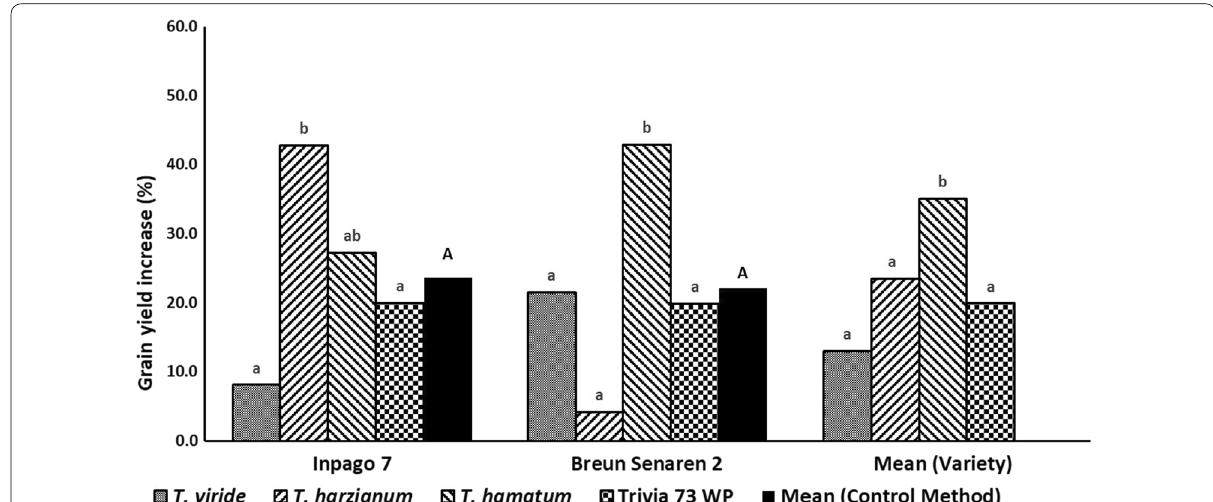
Fig. 1 Mean percentage of grain yield increase under combined treatments of disease control method and upland rice variety. Lowercase denotes comparison among disease control methods within the same variety or mean variety; uppercase denotes comparison between Inpago 7 and Breun Senaren 2. Values/bars within the same group with the identical lowercase or uppercase are not significantly different based on the LSD (0.05) post hoc